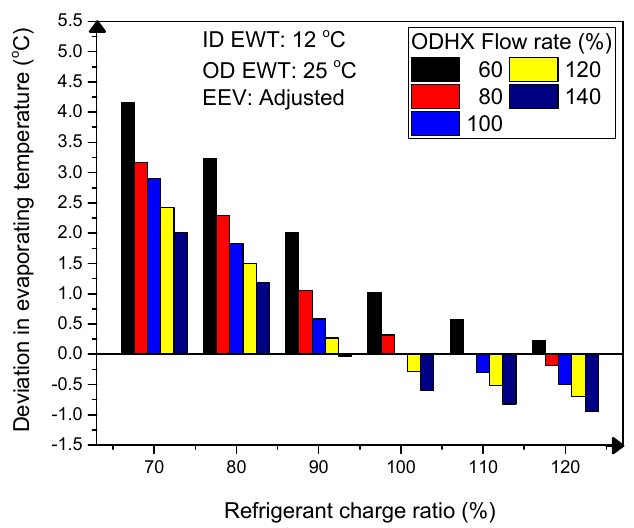
Figure 7. Change in evaporating temperature according to refrigerant charge and outdoor heat exchanger flow rate faults.